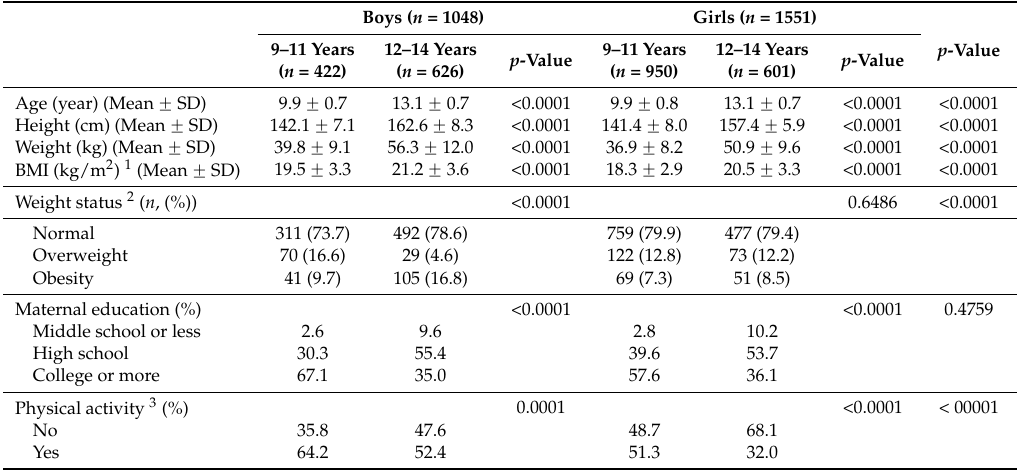
Table 1. General characteristics of study subjects according to gender and age